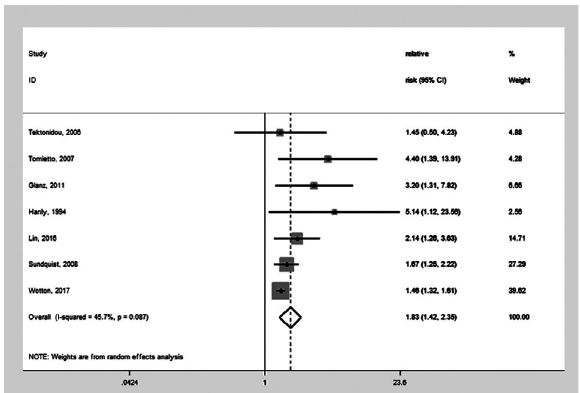
Figure 2. Forest plot for meta-analysis of the studies investigating systemic lupus erythematosus and dementia or cognitive dysfunction (Odds Ratio=1.83).